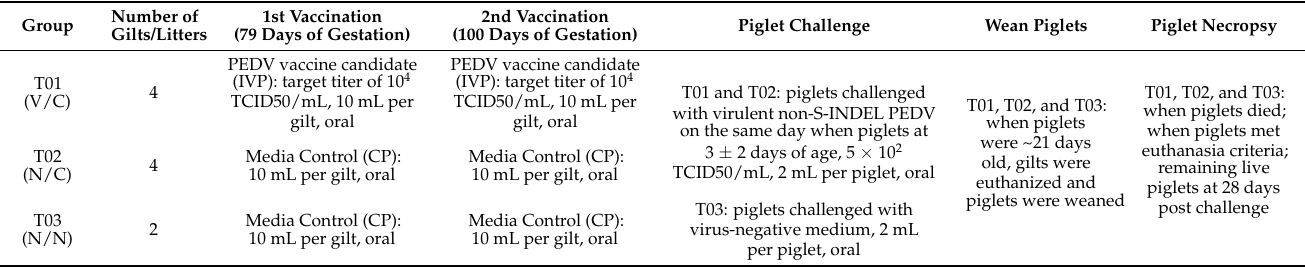
Table 1. Experimental design of vaccination and challenge